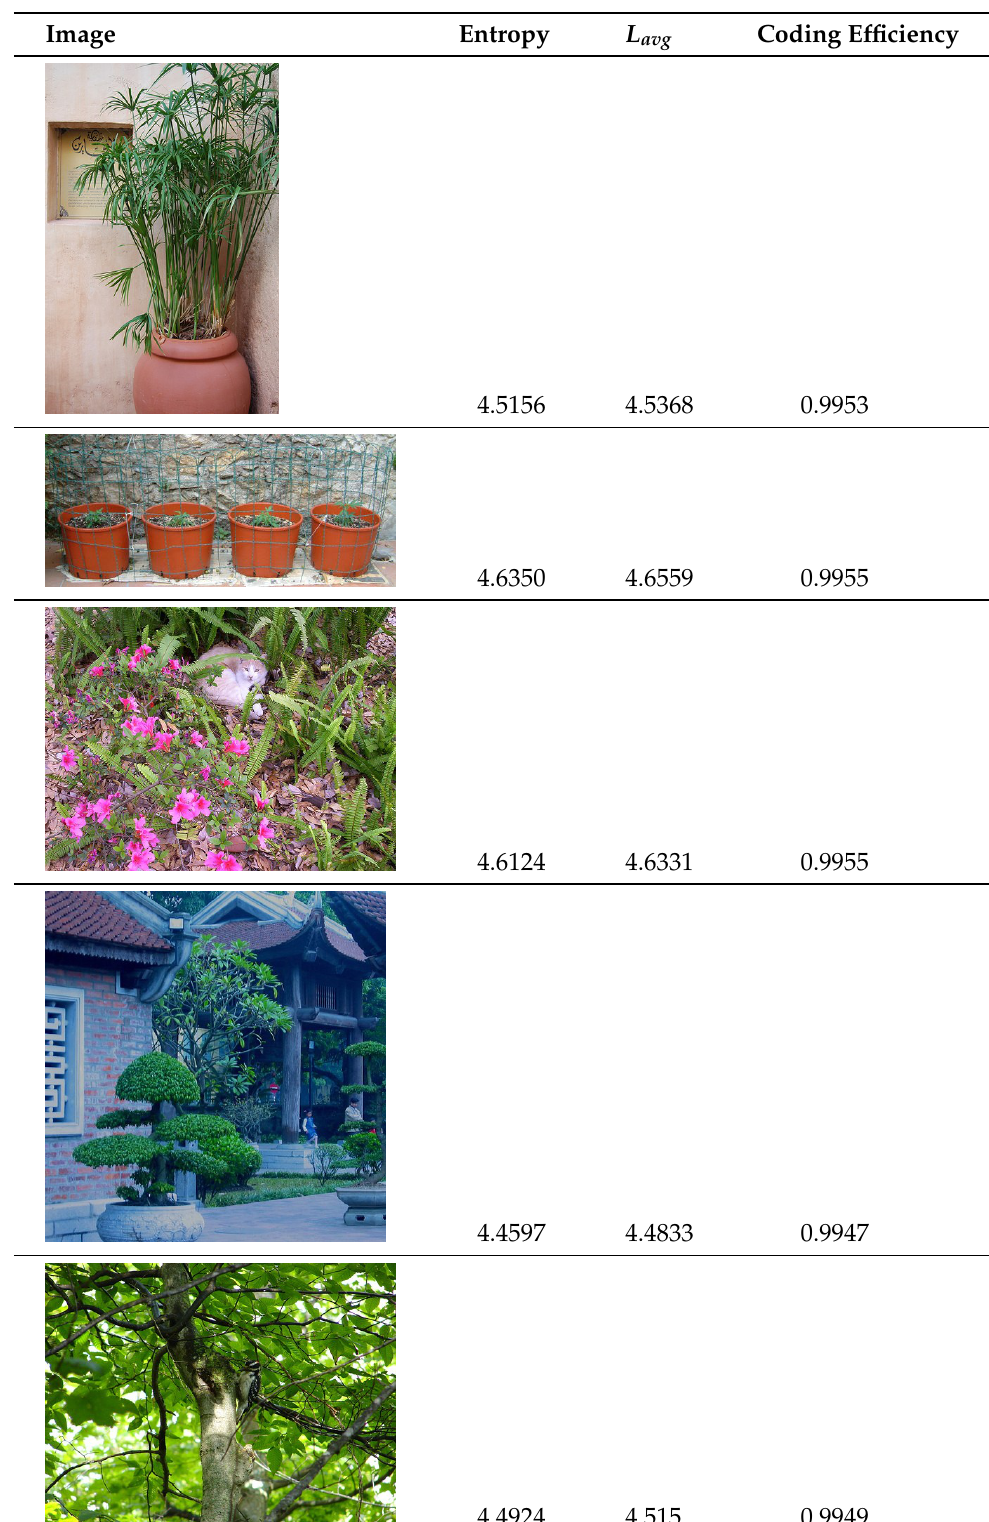
Table 7. The Huffman coding